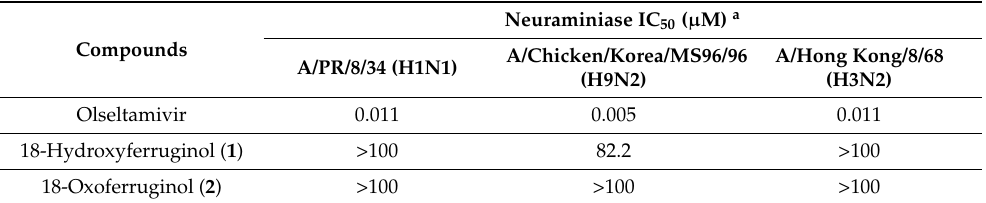
Table 2. Inhibitory activity of 18-hydroxyferruginol ( 1 ) and 18-oxoferruginol ( 2 ) on neuraminidase from influenza A